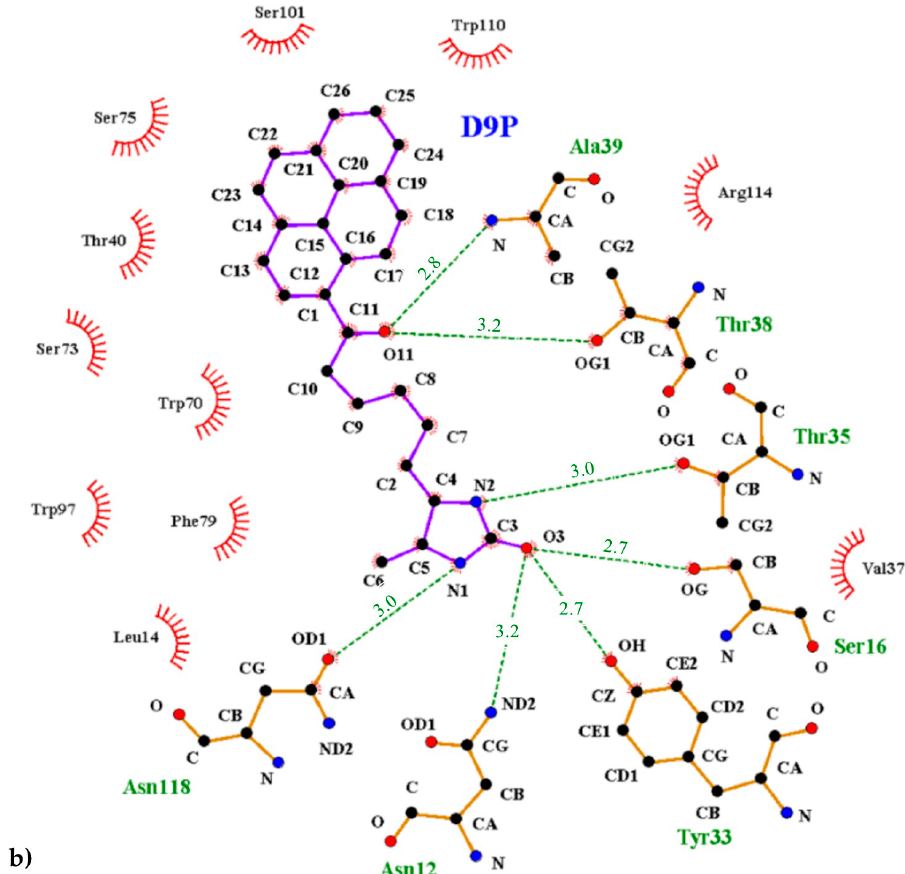
Figure 5. Interactions between the avidin and pyrene conjugates: ( a ) 1-biotinylpyrene and ( b ) 1-desthiobiotinylpyrene. The scheme was prepared with the LIGPLOT+ program [25]. Hydrogen bonds are indicated with a green dashed line, and the residues involved in hydrophobic interactions are shown with red rays.